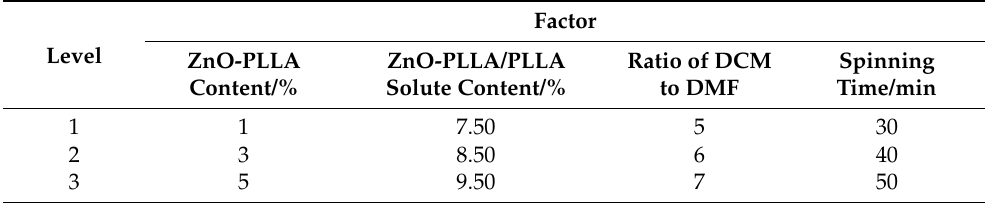
Table 1. Orthogonal experimental design of electrostatic spinning